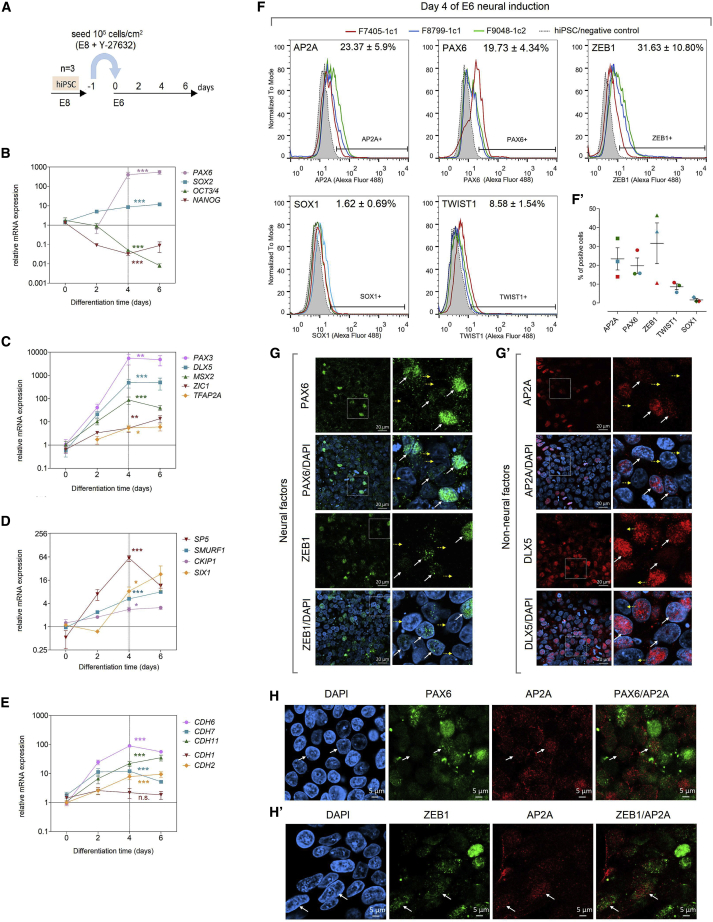
Neural Induction with the E6 Method Produces NPB-like Cells in 4 Days(A) Schematic representation of the E6 induction.(B) Assessment of neural conversion via qRT-PCR for neural fate markers SOX2 and PAX6, and pluripotency markers OCT3/4 and NANOG.(C and D) qRT-PCR for key NPB specifiers PAX3, DLX5, MSX2, ZIC1, and TFAP2A (C) and additional NPB factors SP5, SMURF1, CKIP1, and SIX1 (D) during E6 induction.(E) qRT-PCR for cadherins involved in NC development CDH1, CDH2, CDH6, CDH7, and CDH11. qRT-PCR data are plotted as mean ± SEM (n = 3 biological replicates). ∗∗∗p < 0.001, ∗∗p < 0.01, ∗p < 0.05; ns, not significant; one-way ANOVA with Dunnett's correction.(F and F′) Flow cytometry analysis on day 4 of induction for AP2A, PAX6, ZEB1, TWIST1, and SOX1; values for each sample are plotted in (Fʹ). Bars represent mean ± SEM (n = 3 biological replicates).(G and G′) Representative immunostaining for neural factors PAX6 and ZEB1 (G), and for non-neural factors AP2A and DLX5 (G′) on day 4 of induction (n = 3 biological replicates). White arrows show variable nuclear staining intensity; yellow arrows point to negative nuclei. Right panels are higher-magnification images. Scale bar, 20 μm.(H and H′) Representative double immunostaining for AP2A/PAX6 (H) and AP2A/ZEB1 (H′) on day 4 of induction (n = 3 biological replicates). Arrows point to double-positive nuclei. Scale bar, 5 μm.Related to Figure S1.